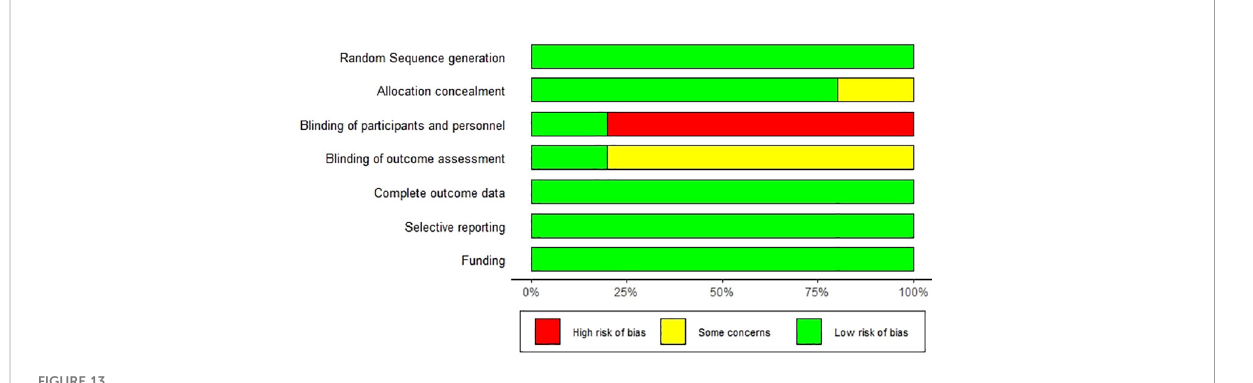
FIGURE 13 Evaluation for bias risk of the included